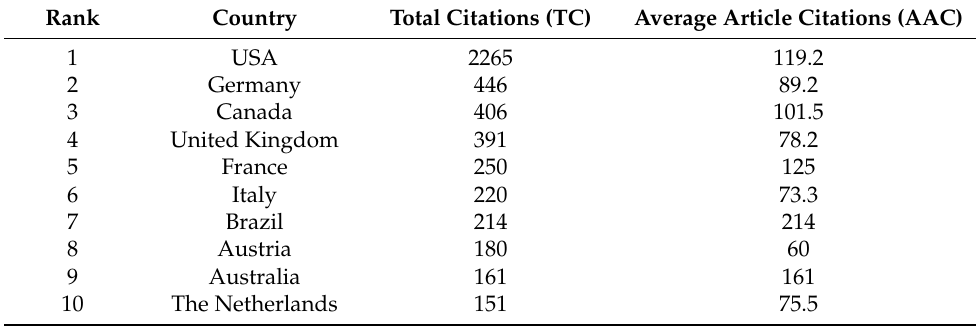
Table 15. Top 10 Most Global Cited Document.